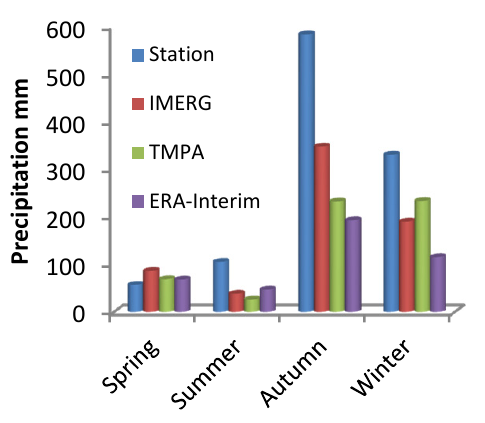
Table 13. Statistical indices of seasonal precipitation in Bushehr area.